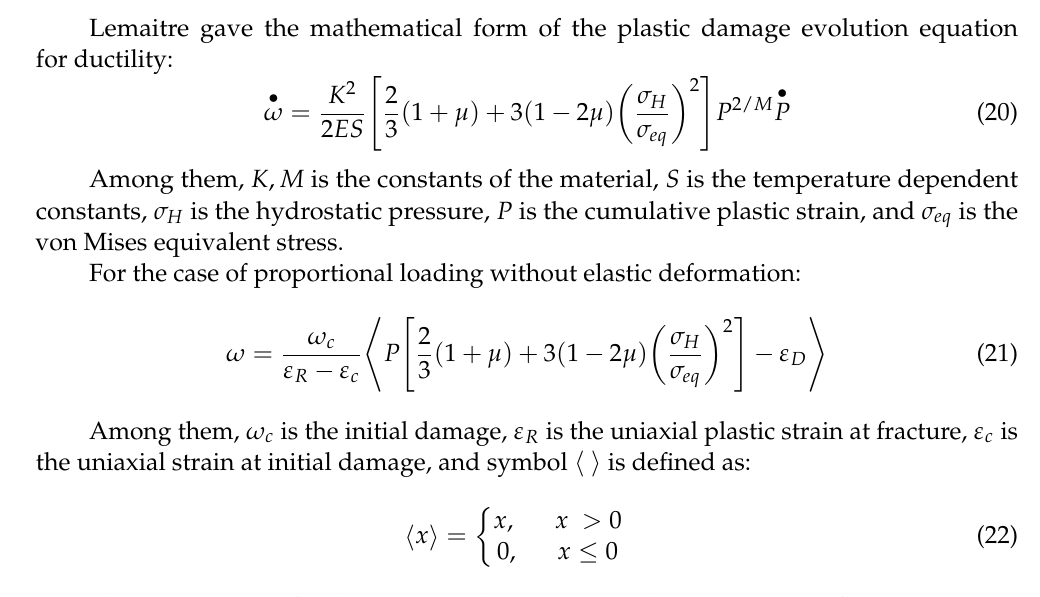
Figure 6. Flowchart of specimen processing. In order to avoid damage to the epoxy resin specimen and nickel–iron/epoxy IPC specimen by the chuck of the testing machine, which makes the specimen fail from its connection with the chuck and affects the accuracy of the test, a fixture was designed to fix the specimen. The fixture and the specimen were connected by pins, and both the fix- ture and the pins were made of Q235 steel, and the shape and dimensions of the fixture are shown in Figure 8. Figure 7. Diagram of tensile loading process of foam Ni-Fe/epoxy composite: ( a ) original specimen; ( b ) damaged specimen.